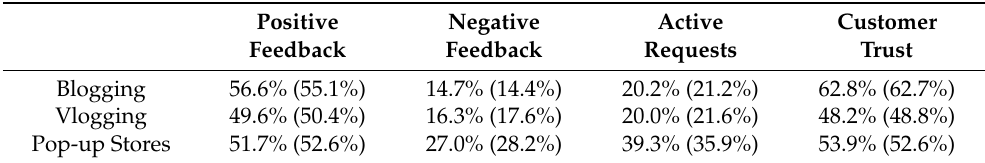
Table 6. Regular customer participation (always, often, or sometimes) by type of new professional service. Numbers in brackets refer to the 18–34 years of age customer